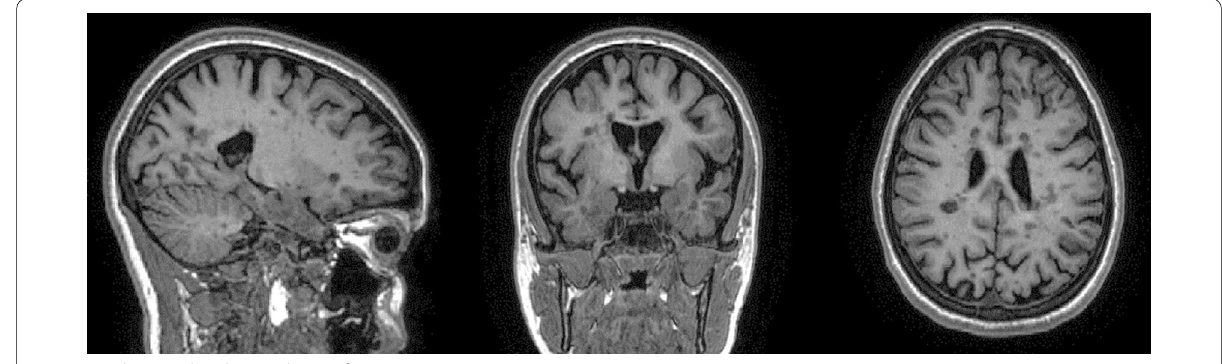
Fig. 1 Axial, coronal and sagittal cuts of 3DT1 images